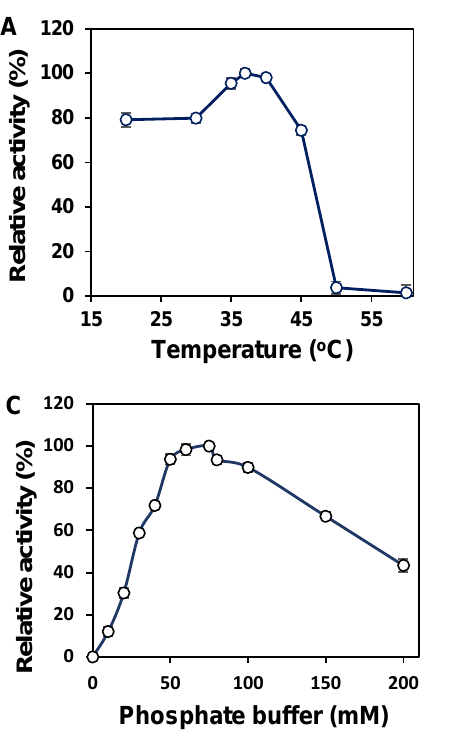
Figure 2. Biochemical characterization of the recombinant Chon-ABC. The effects of temperature ( A ), pH ( B ), PBS concentration ( C ), and metal ions and surfactant ( D ) on the enzyme activity at 37 °C.